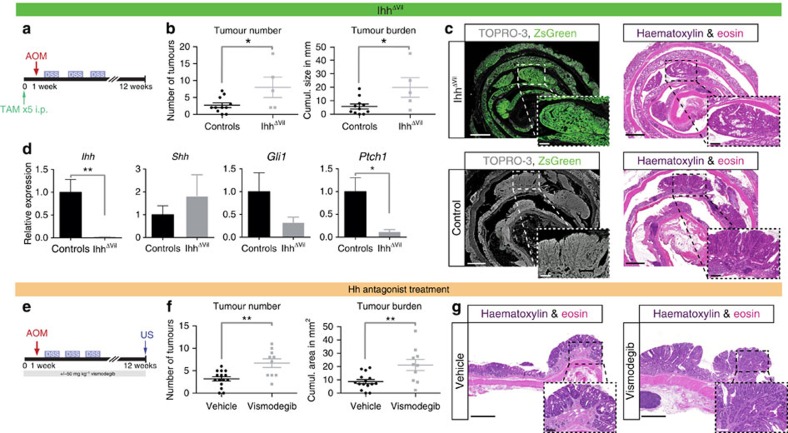
Reduced Hh signalling increases tumour burden in the AOM/DSS model.(a) Schematic of Tam and AOM/DSS treatment of IhhΔVil mice. (b) Tumour numbers and tumour burden for IhhΔVil mice (n=13) and controls (n=11 littermates that lacked either the VillinCreER allele or floxed Ihh alleles or both): 5/13 IhhΔVil mice and 11/11 controls reached the endpoint; P=0.0321 (tumour numbers), P=0.0215 (tumour burden; both t-tests). (c) Representative confocal image of ZsGreen reporter fluorescence in an IhhΔVil mouse (upper left panel). Persistent reporter expression indicates enduring loss of Ihh in the tumour. Haematoxylin and eosin (H&E) staining of consecutive section (upper right panel). Littermate wt controls are shown in the lower panels. Dashed boxes show magnified areas. Nuclear counterstain: TOPRO-3. Scale bars, 1 mm/250 μm. Representative image of n=2 IhhΔVil mice with n=8 tumours, in which all tumours expressed ZsGreen, whereas no zsGreen expression was detected in n=3 control mice. (d) Real-time quantitative PCR (RT-qPCR) for the indicated transcripts in IhhΔVil mice (n=5) and controls (n=5); P=0.003 (Ihh), P=0.887 (Shh), P=0.311 (Gli1), P=0.0142 (Ptch1; all t-tests, P-values after multiple test correction (fdr)). Bars represent mean and whiskers represent s.e.m. (e) Schematic of tumour induction, vismodegib treatment and tumour quantification with US; wt C57BL/6 mice received either 25 mg kg−1 vismodegib or vehicle (DMSO) twice daily, 6 days per week. (f) Tumour numbers and tumour burden for mice treated with vehicle (n=16) or vismodegib (n=15): 15/16 DMSO-treated and 10/15 vismodegib-treated mice reached the endpoint; P=0.0014 (tumour numbers), P=0.0036 (tumour burden; both t-tests). (g) Representative histology of tumours from the indicated treatment groups (H&E); scale bars, 1 mm/200 μm. *P<0.05, **P<0.01 and ***P<0.001.